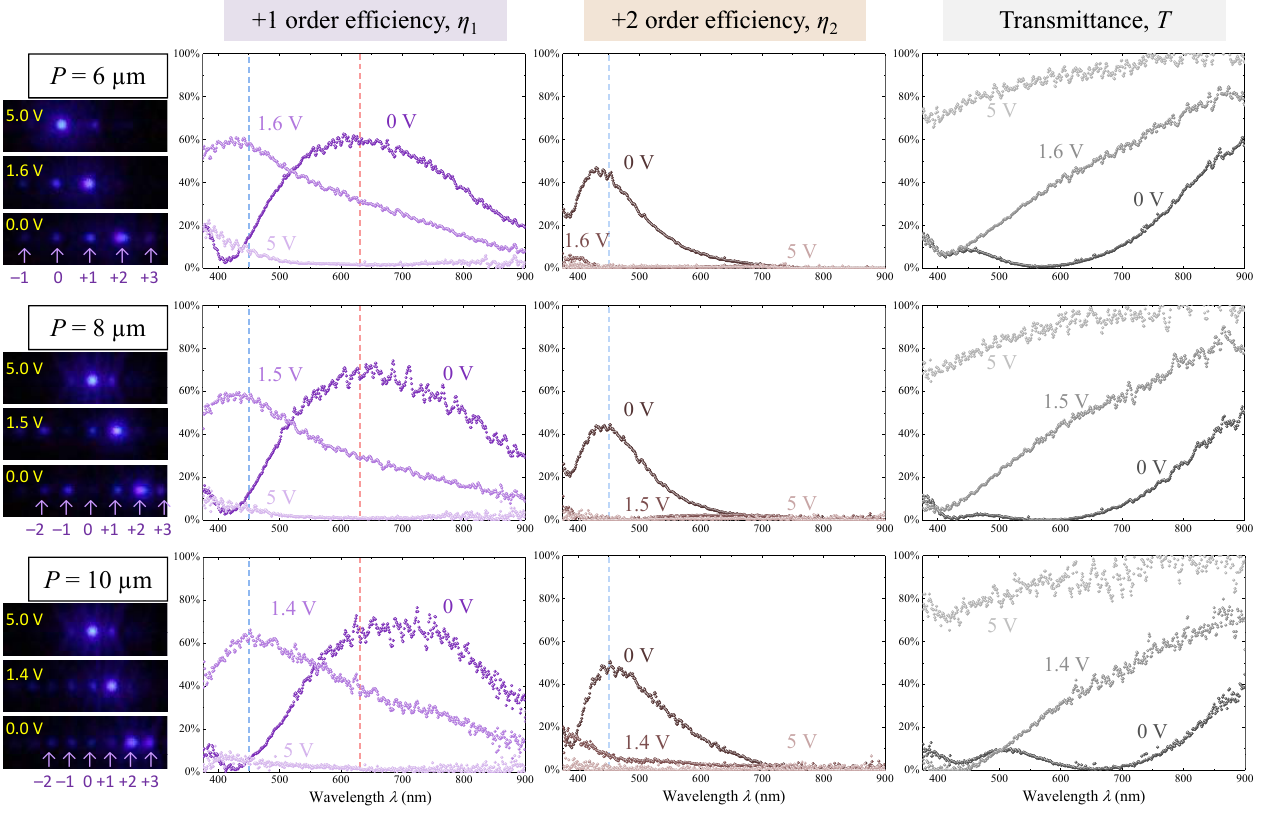
Figure 3. Measured visible light diffraction by experimental double-sided LC-metasurfaces of periods 6 µ m ( top row ), 8 µ m ( middle row ) and 10 µ m ( bottom row ). Three operations modes of each metasurface are illustrated by the corresponding BFP POM images upon blue light illumination and the spectra of diffraction efficiencies of +1 and +2 orders and the direct transmittance. Target wavelengths of 450 nm and 630 nm are indicated by the vertical dashed lines.